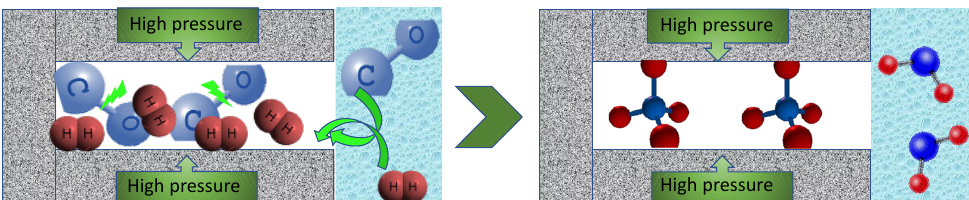
Figure 5. ( a ) Increase in the Faradic efficiency for CO and CH 4 formation on nitrogen-modified com- mercial carbon upon duration of a catalysts electroreduction process prior to CO 2 ERR, and ( b ) de- pendence of the amount of CH 4 formed upon the amount of CO formed. Adapted with permission from Reference [47]. Copyright 2017, Elsevier.